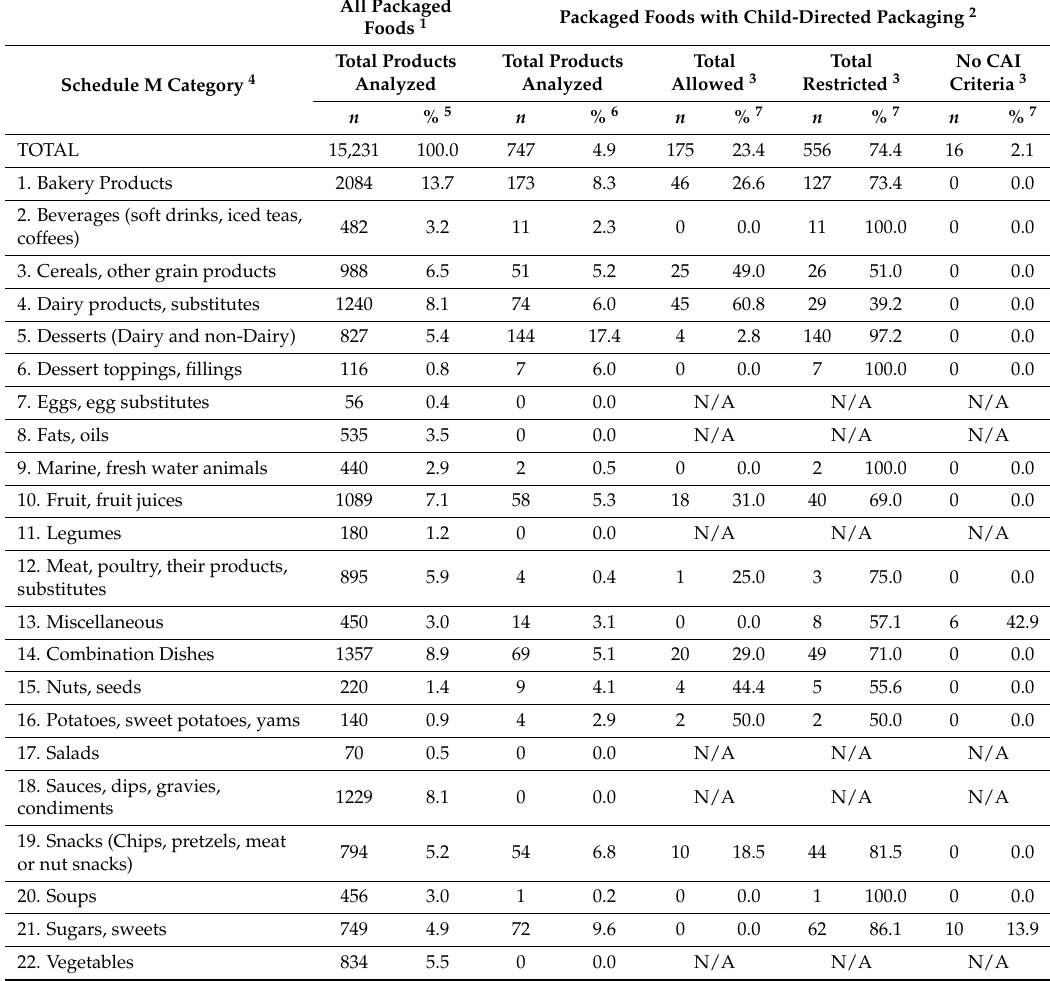
1 Packaged food products are from the Food Label Information Program (FLIP) 2013 database, as described in [22]. 2 Products with child-directed packaging were identified using criteria based on previous publications [23]. 3 Canadian Children’s Food and Beverage Advertising Initiative’s (CAI) Uniform Nutrition Criteria are defined in: Advertising Standards Canada. Canadian Children’s Food and Beverage Advertising Initiative ; Uniform Nutrition Criteria White Paper; September 2014 [17]. 4 Food categories are defined in Schedule M of the Food and Drug Regulations (C.R.C., c. 870), Sections B.01.001, B.01.002A and D.01.001, Government of Canada, Health Canada